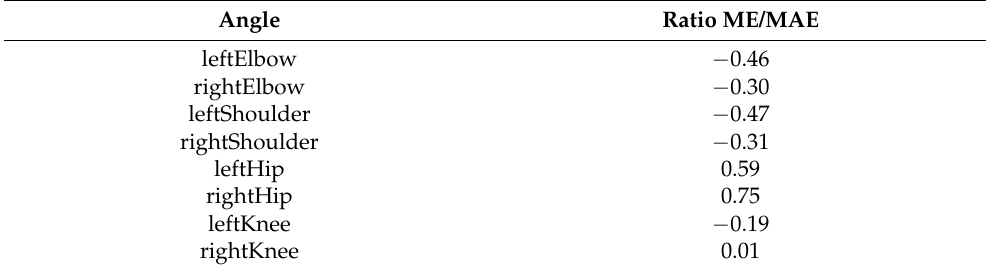
Table 8. The mean values of the ratio ME/MAE for the different joint angles. Angle Ratio ME/MAE leftElbow − 0.46 rightElbow − 0.30 leftShoulder − 0.47 rightShoulder − 0.31 leftHip 0.59 rightHip 0.75 leftKnee − 0.19 rightKnee